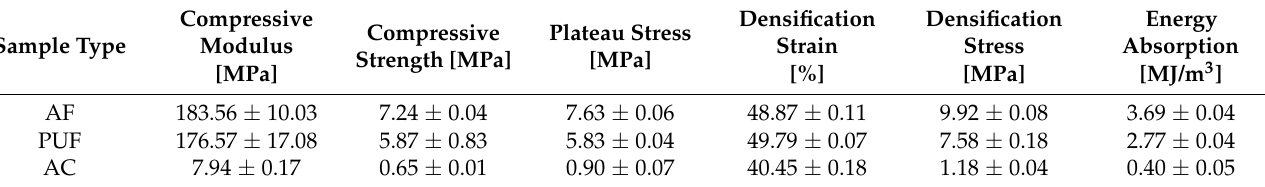
Table 1. Results of the quasi-static compressive tests.